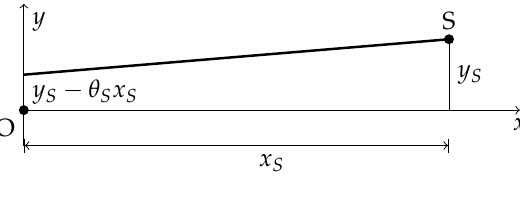
Figure 3. Zeroth-order